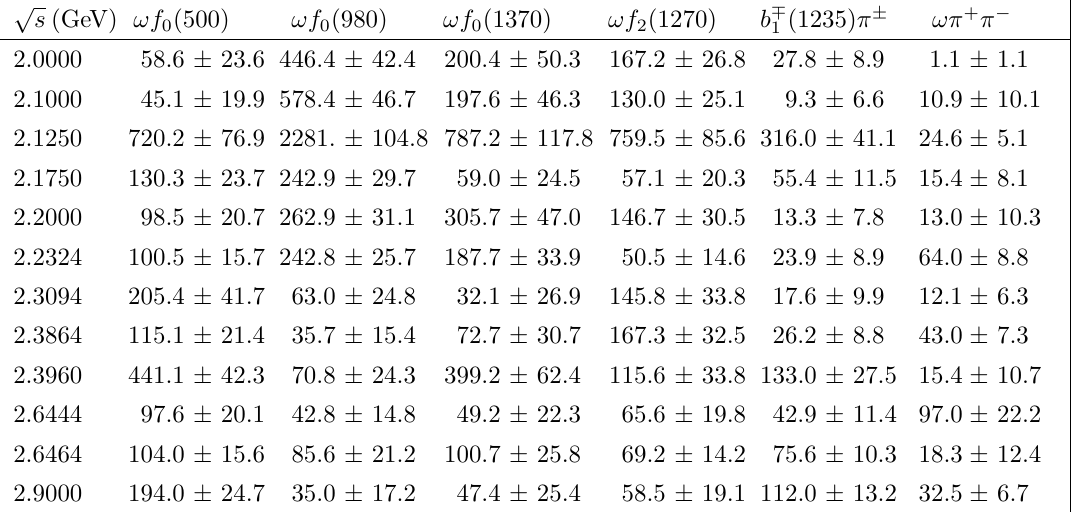
Table 3 . Signal yields of the subprocesses at various selected energy points, where the uncertainties are only statistical. The last column is the non-resonance